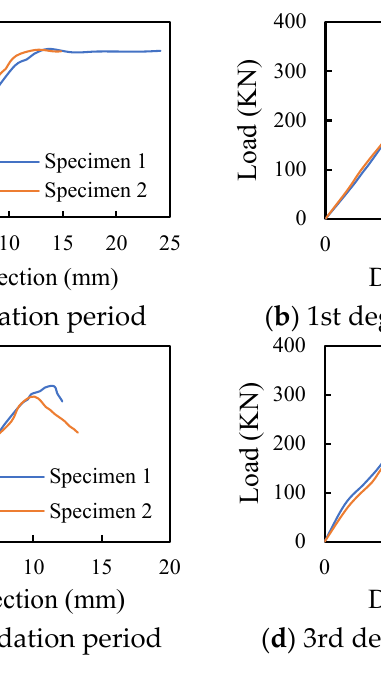
Figure 12. Four-point bending failure test setup of degraded, reinforced concrete beams (unit: mm). According to the four-point bending failure test results, load versus mid-span deflec- tion curves in the mid-span of degraded reinforced concrete beams in the degradation periods 0–10 are drawn in Figure 13. In the approximate elastic stage, the slopes of load- deflection curves gradually increase with the degradation periods. It should be noted that the load–deflection curve of the 6th degradation period does not show a yield point of degraded, reinforced concrete beams compared with other curves. The reason may be that the linear variable displacement transducers loosen in the four-point bending failure test.